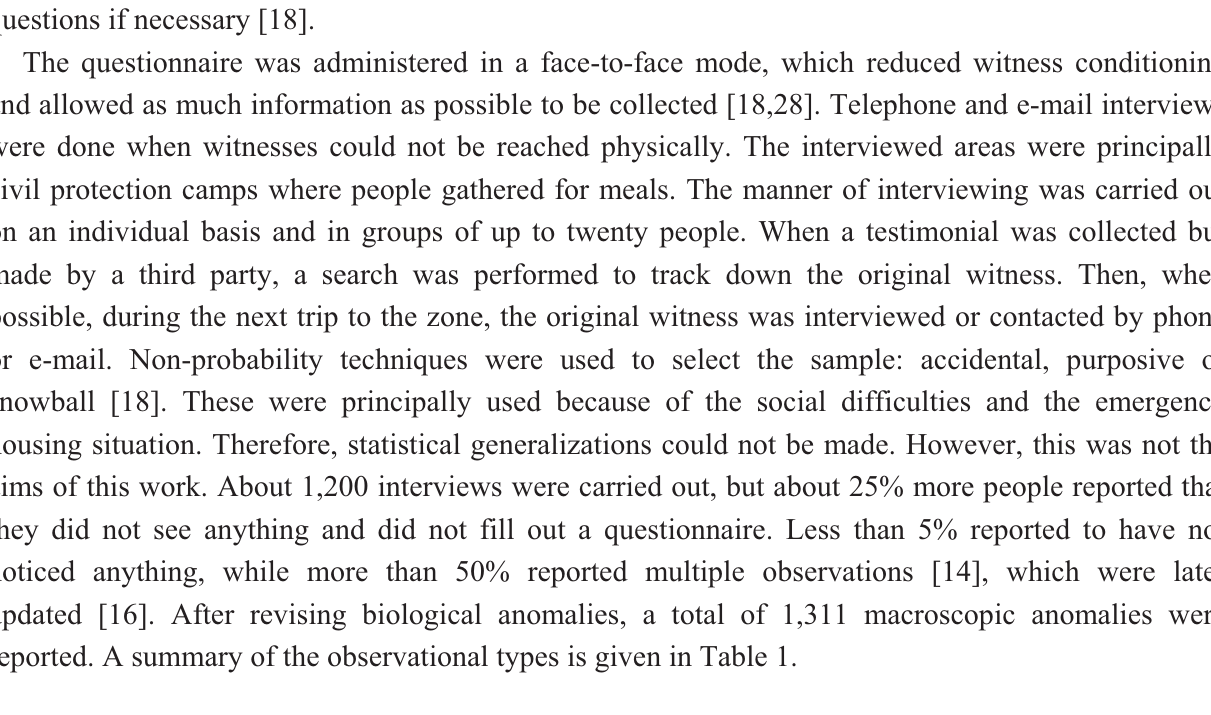
Table 1. Types of observations with respect to the distance from